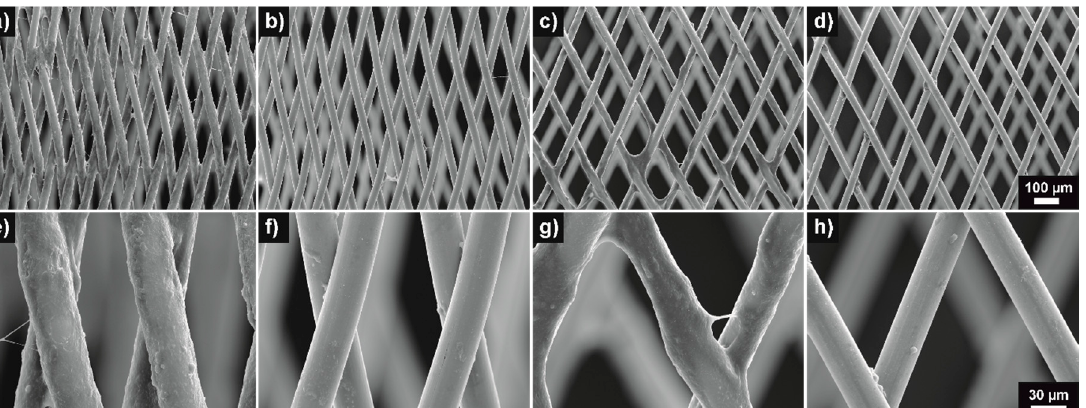
Figure 5. Representative scanning electron microscopy (SEM) images (in secondary electron contrast) of coated ( b , d , f , h ) and uncoated ( a , c , e , g ) NiTi ( a , b , e , f ) and CoCr ( c , d , g , h ) devices after incubation in whole human blood in a modified Chandler loop flow model under dynamic conditions at 37 °C for 120 min. The uncoated devices were completely covered with adherent platelets and fibrin clots, while only a few cells adhered to the pHPC-coated devices. (Scale bar for the upper row 100 µ m, scale bar for the lower row 30 µ